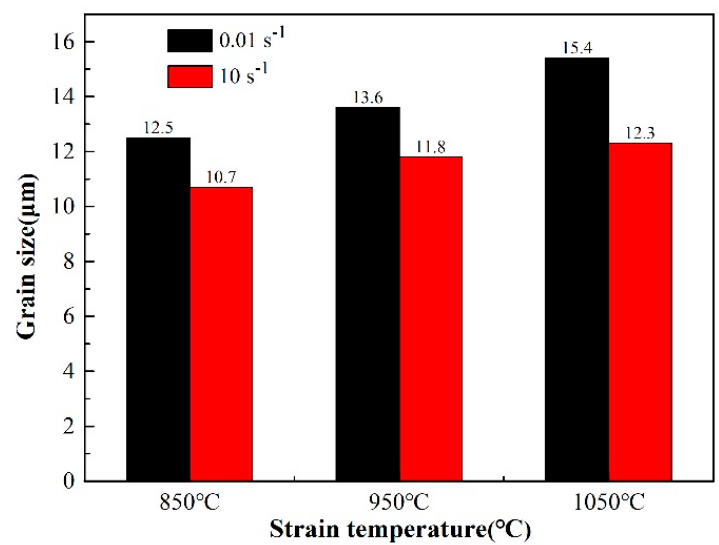
Figure 3. Grain size of 35CrMoV steel at different deformation temperatures and strain rates.